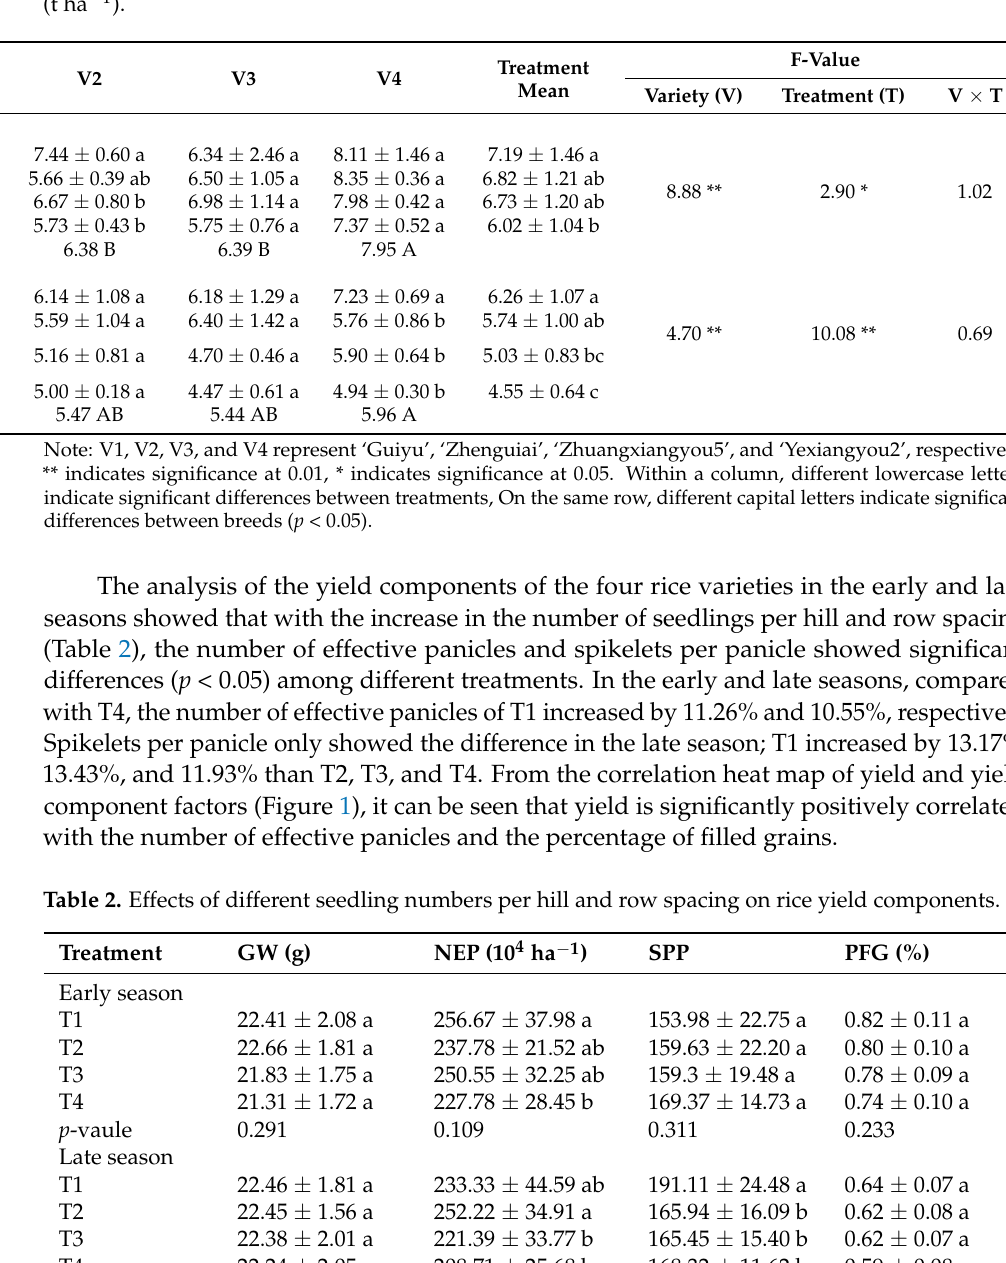
Table 1. Effects of seedling numbers per hill and row spacing on yield of different rice varieties (t ha − 1 ).